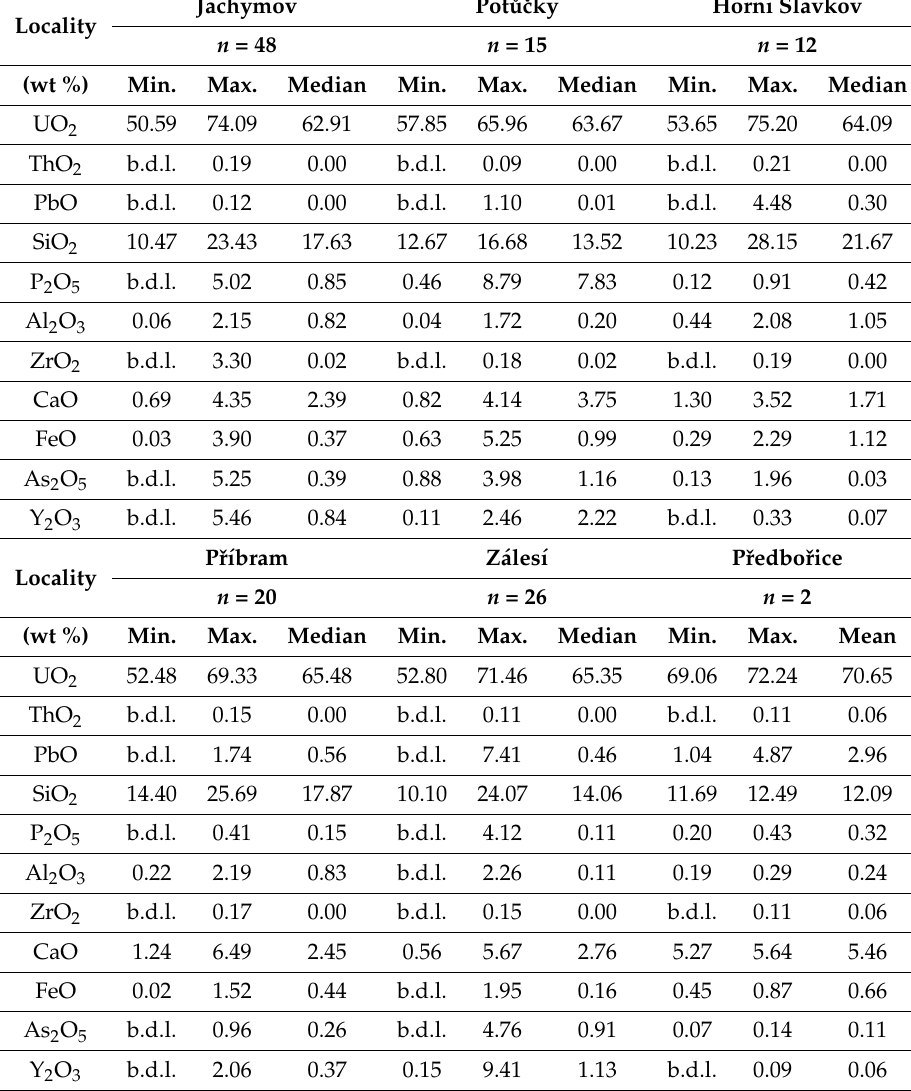
Table 2. Concentration ranges of selected components in coffinite.